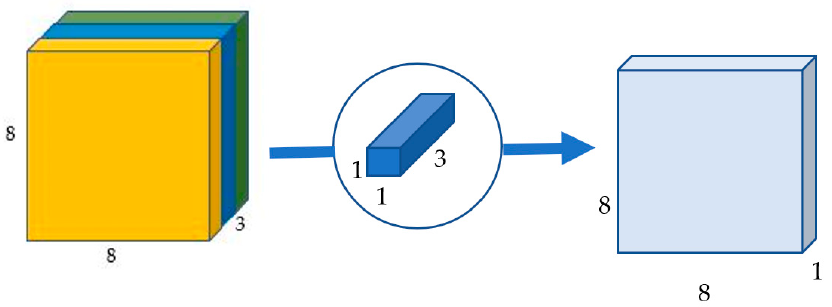
Figure 7. Point-wise convolution transforms an image of three channels into an image of one chan- nel.